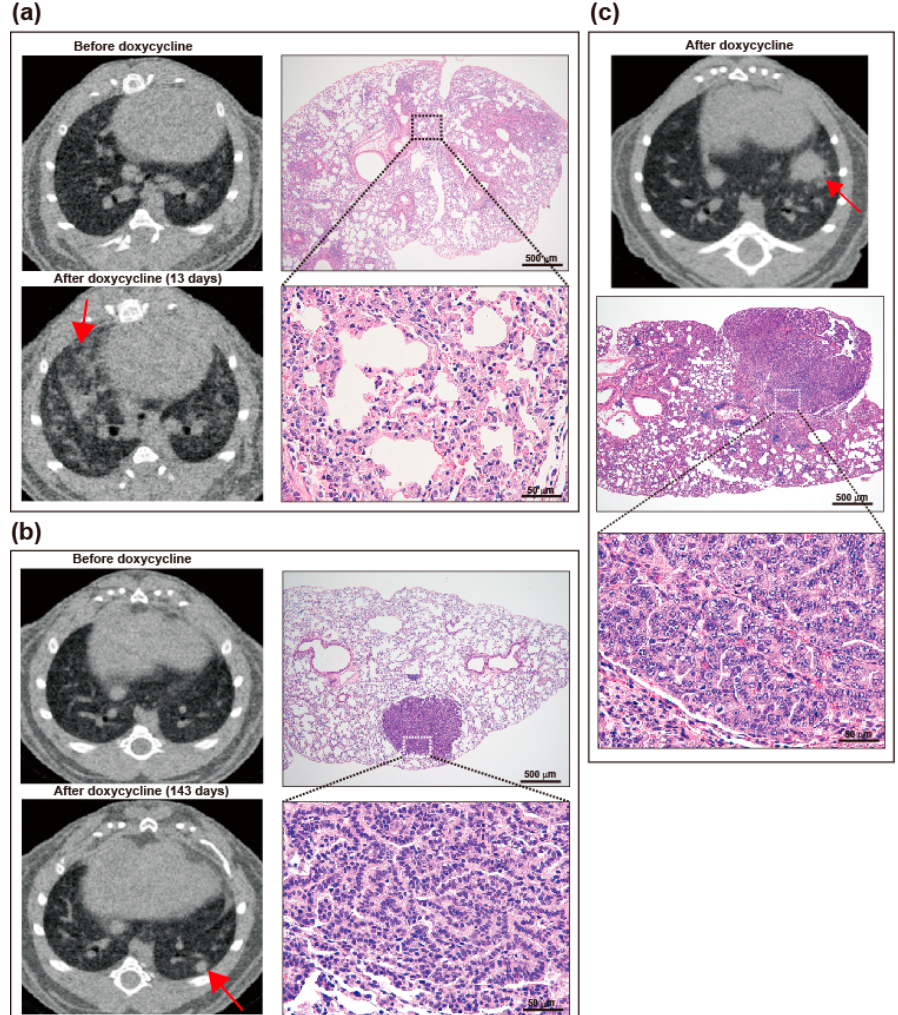
Figure 3. Induction of lung tumors in bitransgenic mice after doxycycline administration. CT and pathological findings of lepidic ( a ) and papillary ( b ) types of lung adenocarcinoma induced on doxycycline diet in bitransgenic mice with [L858R]-hEGFR mutation. ( c ) CT and pathological findings in a papillary type of lung adenocarcinoma induced on a doxycycline diet in bitransgenic mice with [L858R + T790M]-hEGFR mutation. Scale bars indicate 500 µ m (upper panel in a – c ) and 50 µ m (lower panel in a – c